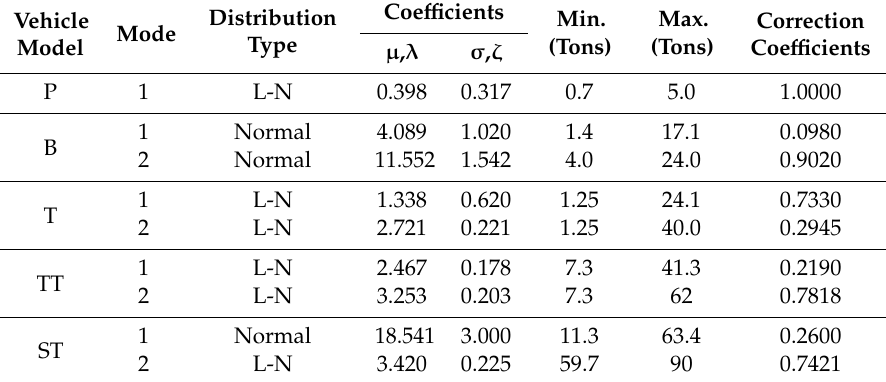
Table 3. Probabilistic characteristics of the vehicle weight model